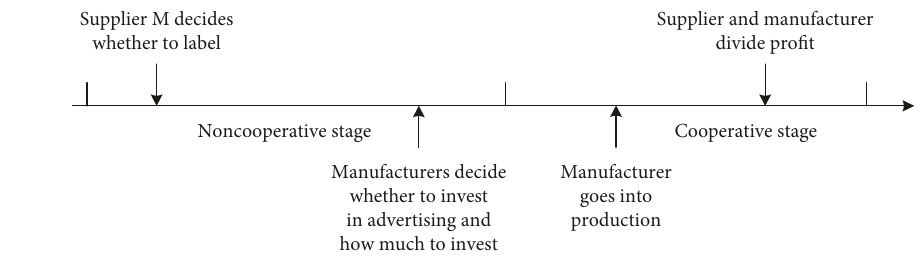
Figure 5: Decision sequence of players in AIGM. Table 4: Expected benefits of supplier M in